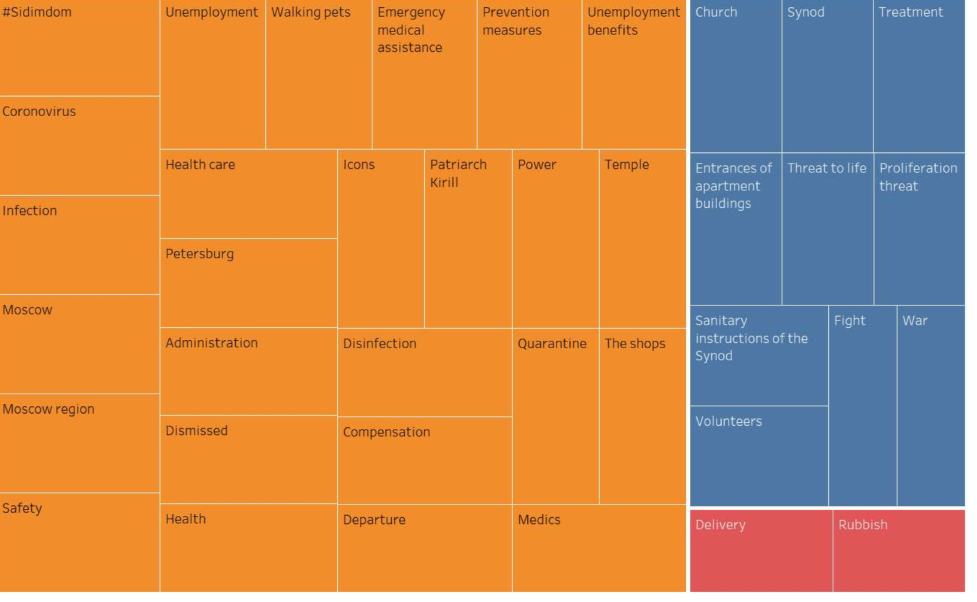
Figure 7. Core of the semantic network of the regional actors’